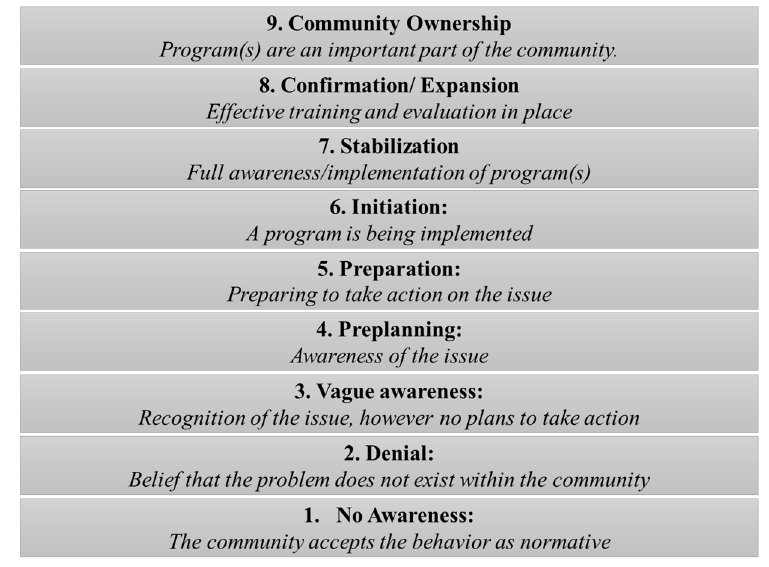
Figure 2. Nine stages of community readiness, as determined through the scoring process.